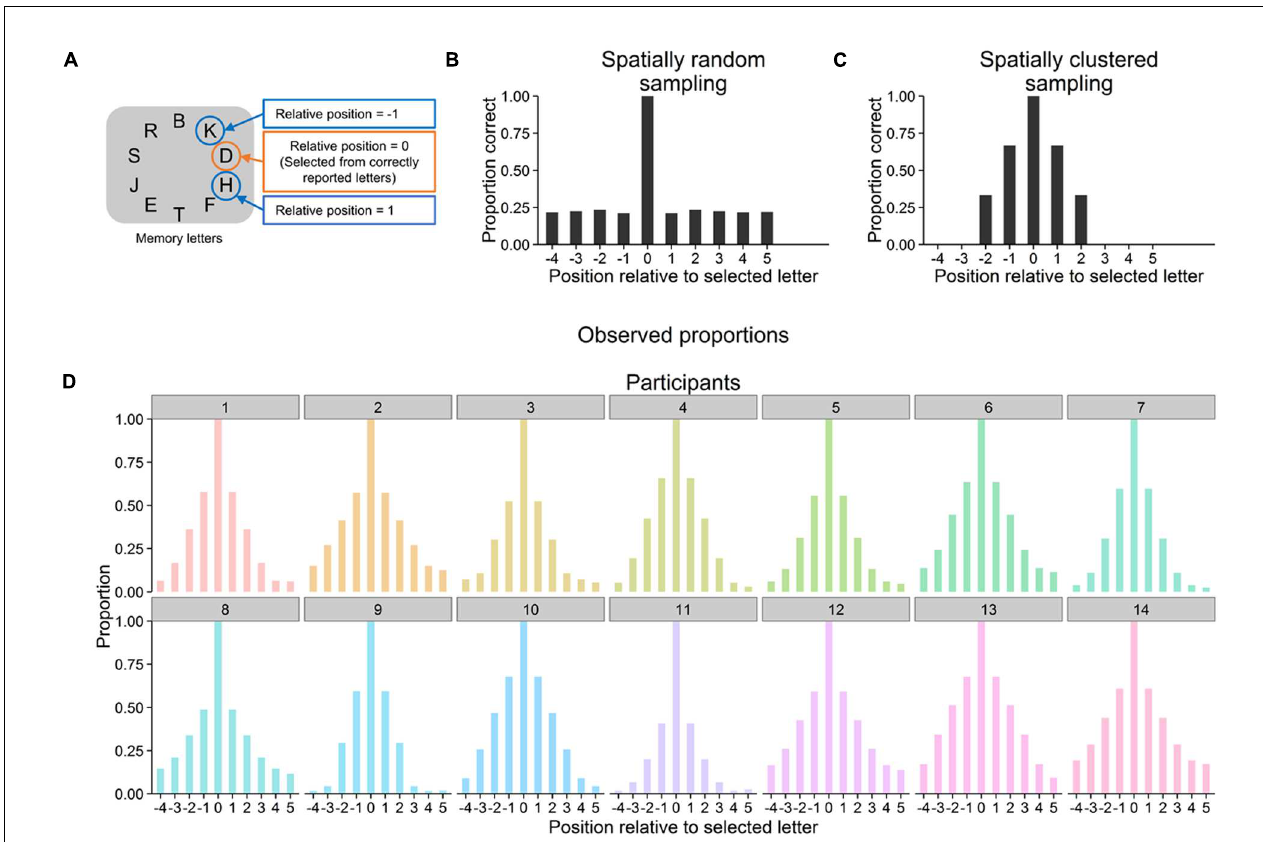
FIGURE 2 | (A) For each correctly reported letter, it was determined whether letters at the 10 relative positions in the display of memory letters were reported as well. Averaged across all correctly reported letters, this resulted in a proportion of correctly reported letters for each relative position. (B) Simulation of 1000 trials in each of which three letters were randomly sampled from the display of memory letters. Proportions of correctly reported letters are shown as a function of position relative to a selected correctly reported letter (averaged across trials). Proportions are approximately equal for all relative positions except for the position of the selected letter (which must always equal one). (C) Simulation of 1000 trials in each of which three letters were sampled that where next to each other in the display of memory letters. Proportions monotonically decrease from relative positions closer to selected letters to relative positions farther away from them. (D) For each individual participant, observed proportions of correctly reported letters as a function of position relative to a selected reported letter (across all correctly reported letters and averaged over all trials).